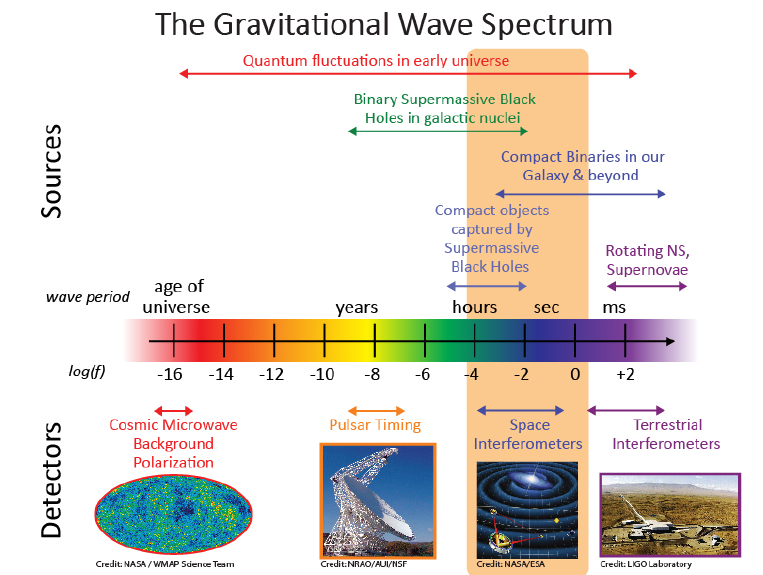
Figure 16: The spectrum of gravitational waves with possible sources and detectors.